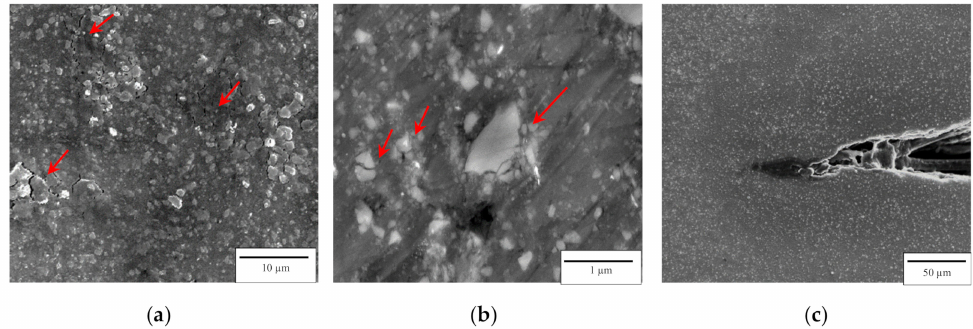
Figure 3. ( a ) SEM micrograph showing microcracks at 10% strain, ( b ) HRSEM micrograph showing broken submicron SiC particles at 20% strain in the compression-deformed M10S µ composite, and ( c ) SEM micrograph showing a cracking path within the microstructure of M10S µ at 20%